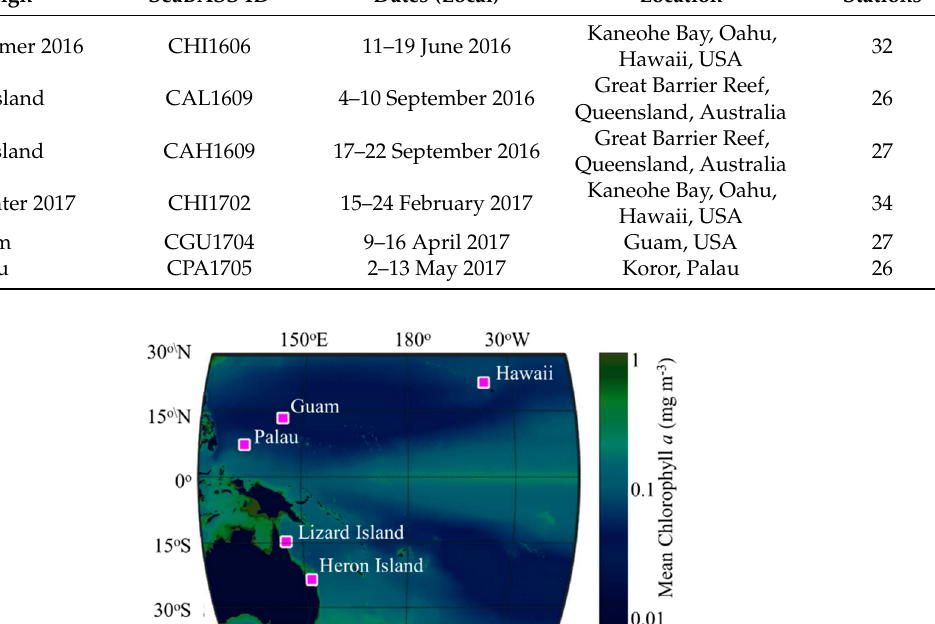
Table 2. Locations and dates of the field campaigns and the number of high quality stations sampled. Campaign